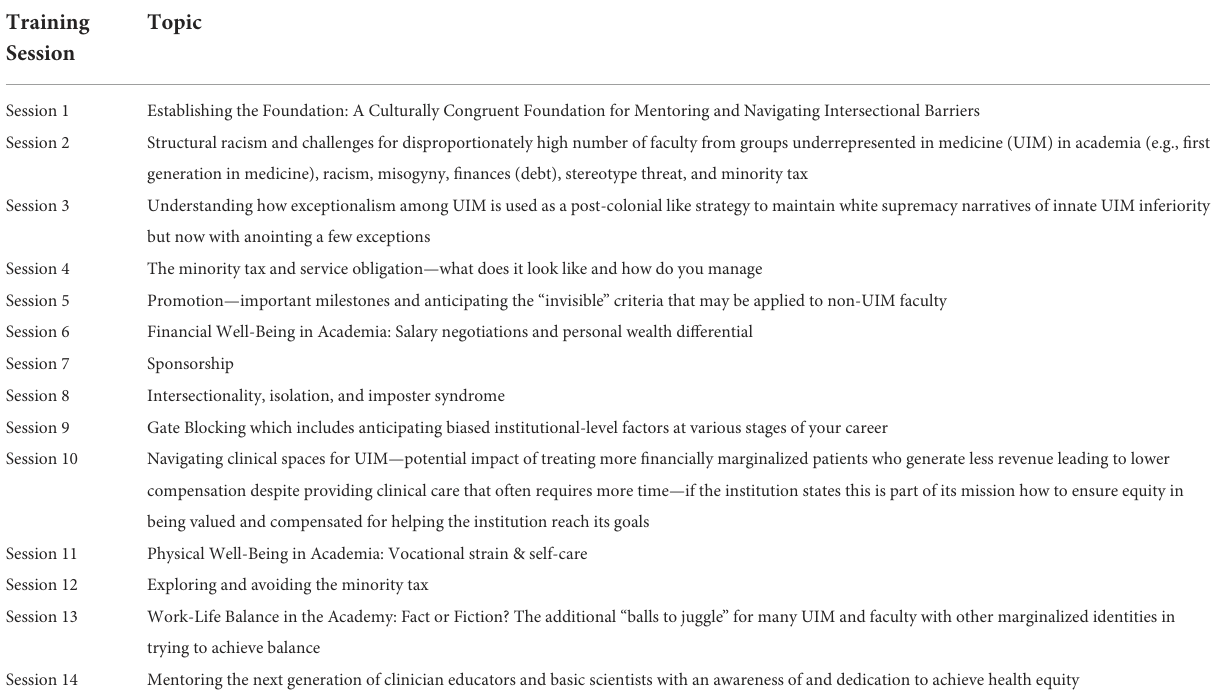
TABLE 3 JAM council 16 session